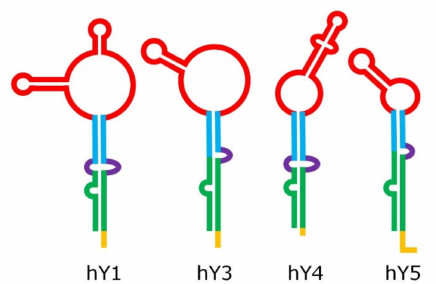
Figure 2. Structure of human Y RNA. The structure was retrieved from the literature [19,21,22], but alternative structures with minor di ff erences have been reported as well [23,24]. The domains are the poly-U tail (yellow), the lower stem (green), the bulge (violet), the upper stem (blue), and the loop (red).